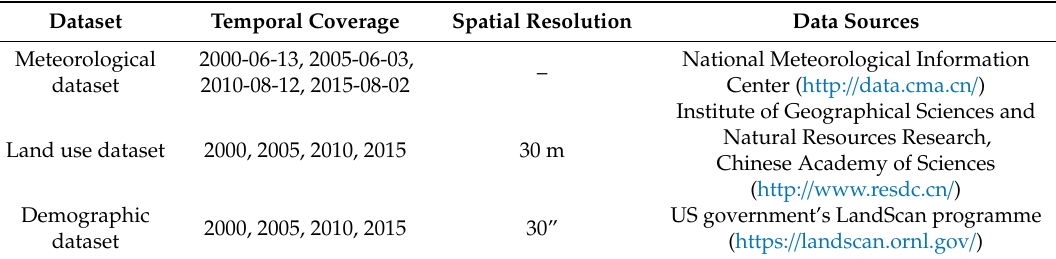
Table 2. List of auxiliary datasets used in this